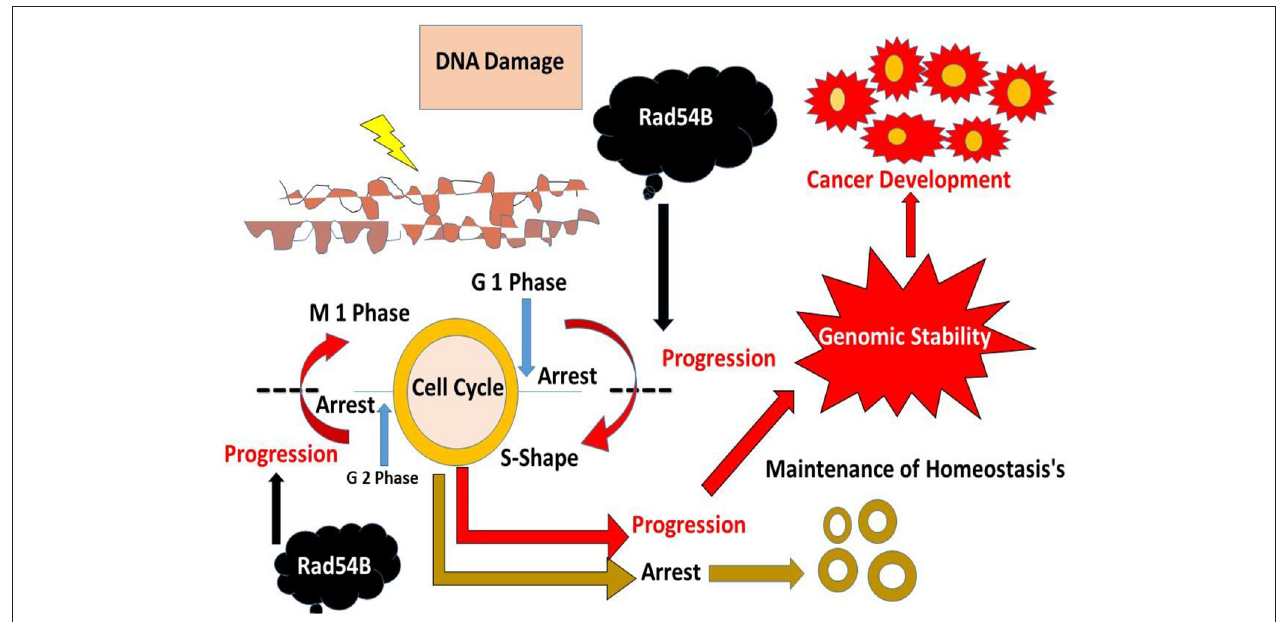
FIGURE 1 | The different mechanisms of cancer and its progression.